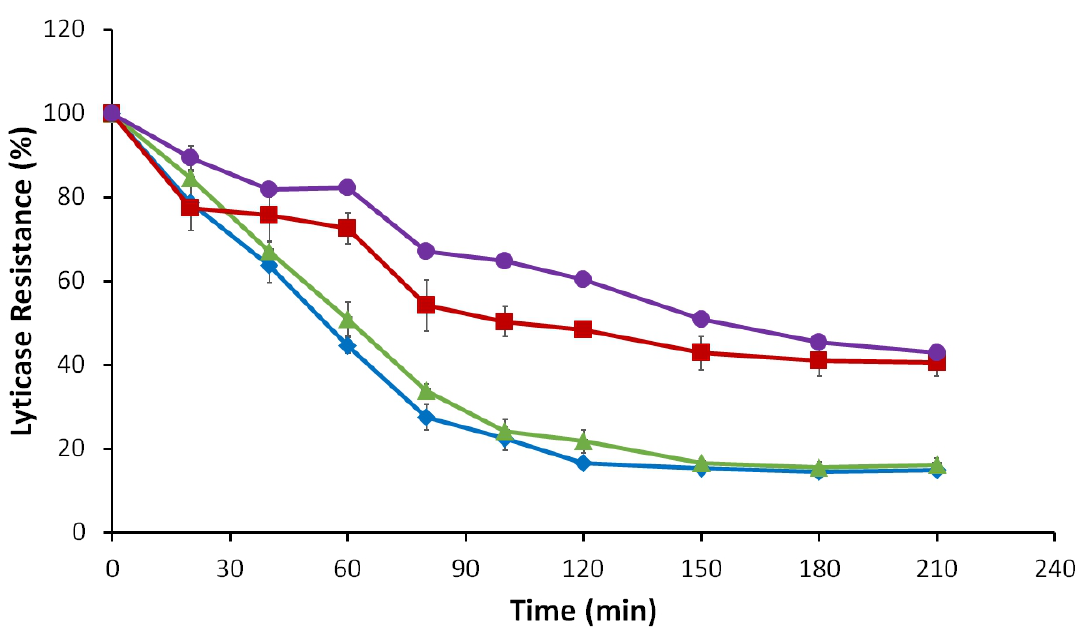
Figure 8. Lyticase susceptibilities of 905 and M8FE in the absence and presence of iron stress ( (cid:95) 905 under control condition, (cid:4) 905 under iron stress condition, (cid:78) M8FE under control condition, (cid:8) M8FE under iron stress condition). Lyticase susceptibility was assessed as the percent decrease in lyticase resistance (initial value = 100%).